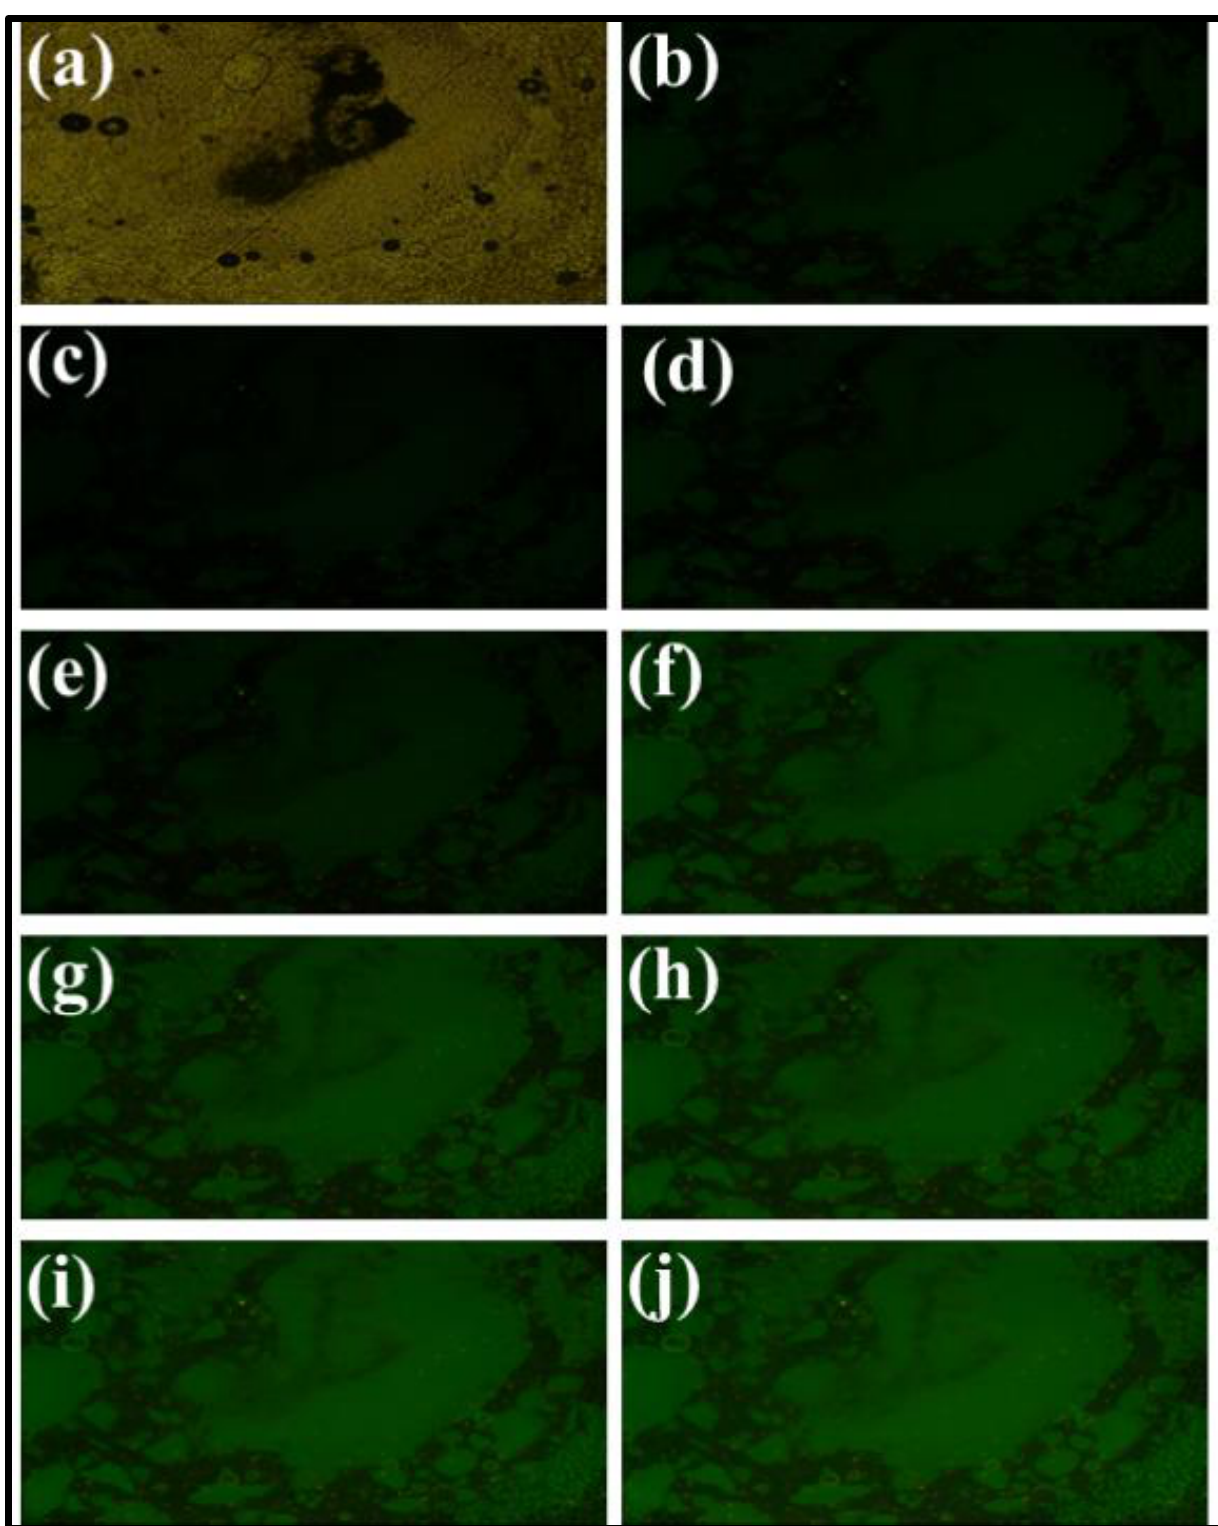
Figure 6. ( a ) Photograph of the sample prepared with NaGdF 4 : Er 3+ /Yb 3+ upconversion phosphor particles for cathodoluminescence under the illumination of white light. ( b – j ) Photomicrograph in transmitted light at different filament currents of canal rays from 0.10 mA to 0.70 mA and the respective CL images.